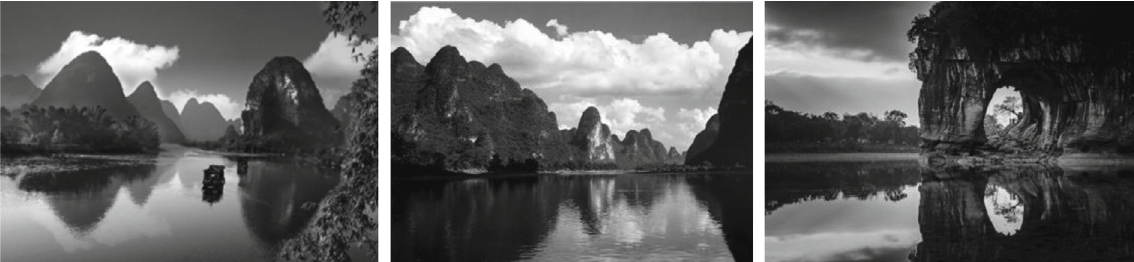
Figure 5: Landscape of